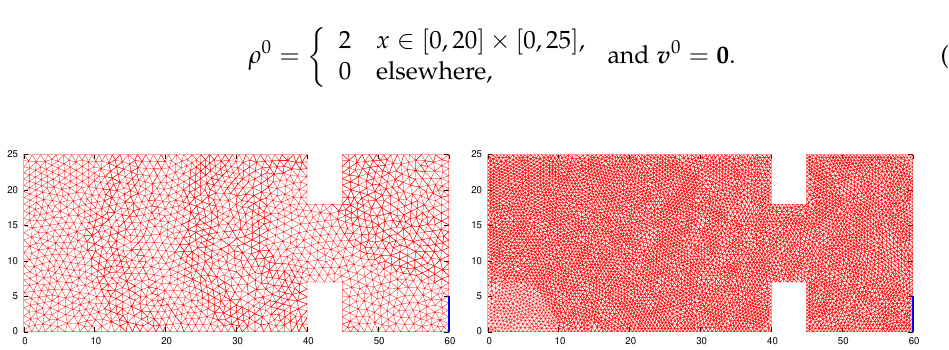
Figure 6. H-shape domain, examples of the computational grids (FV-DG) with # T h = 2941 ( left ) and # T h = 12,742 ( right ) elements, the exits at the right-hand side bottom corner are marked by the blue color.